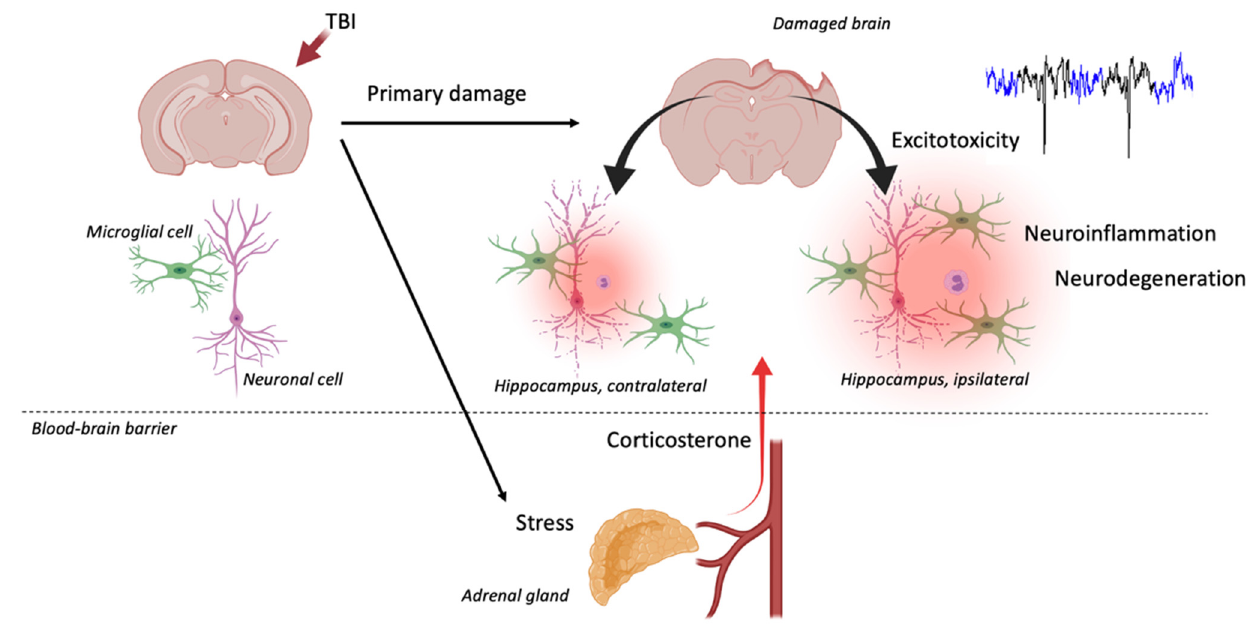
Figure 6. Local and systemic effects of TBI ([54,55]). Based on (1) selectivity and distant character of hippocampal damage, (2) lack of specificity to the type of primary impact leading to distant hip- pocampal damage and (3) involvement of both ipsilateral and contralateral hippocampus in mod- els of unilateral primary neocortical injury, it can be assumed that there are common CS-dependent mechanisms underlying selective death of hippocampal neurons and chronic